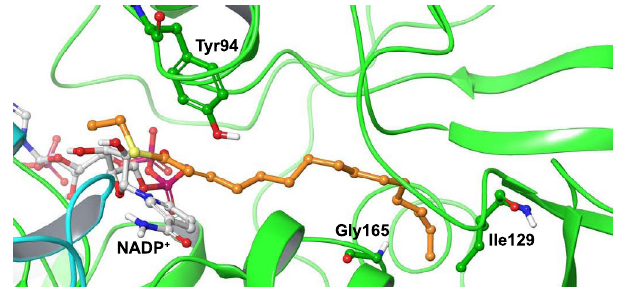
Fig. 2 | The model of the wild-type MECR. The wild-type MECR holoenzyme was modeled based on the crystal structure with PDB entry 2VCY; the cofactor NADP + (whitecarbons)andtheC16-substratefragment(orangecarbons)weremodeled-in based on the C. tropicalis ETR1 crystal structure (PDB entry 4WAS). The two resi- dues mutated in this work and the catalytic residue Tyr94 are shown. The two subunits of the MECR enzyme dimer are displayed as cartoon colored green and cyan. Non-polar hydrogens are not shown.